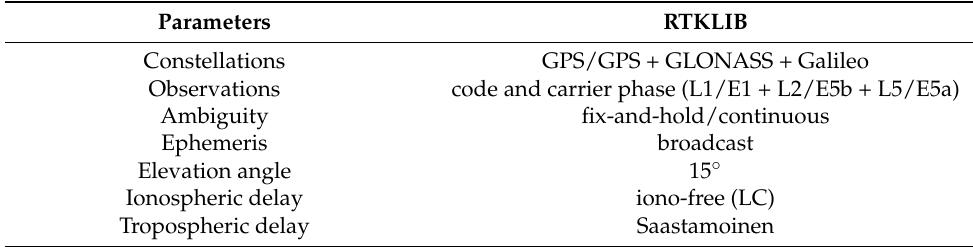
Table 1. Processing parameters used in RTKLIB.